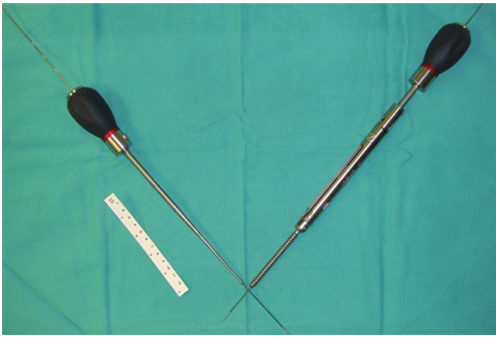
Figure 2: Cannulated 8 mm diameter by 80mm long screws for iliac fixation and cannulated cancellous bone